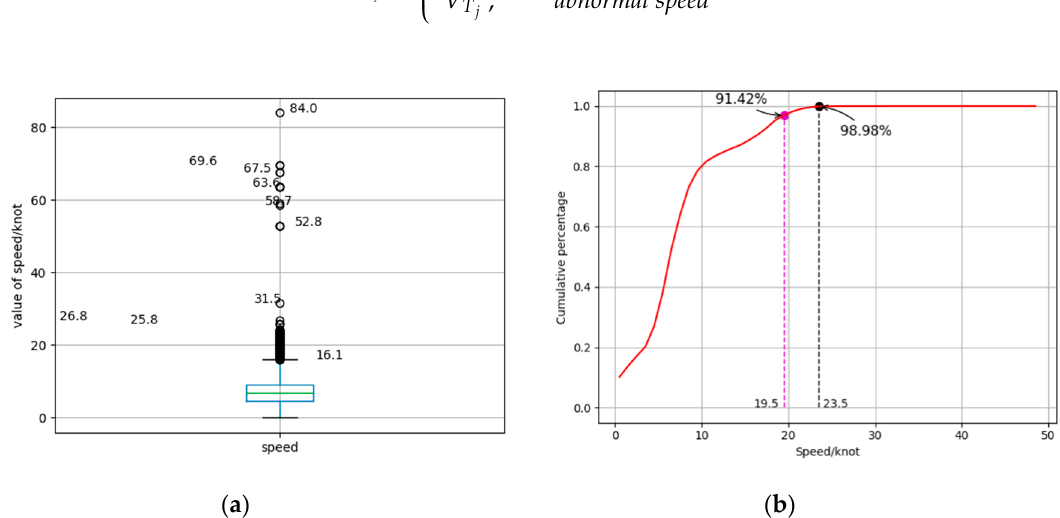
Figure 4. The two forms of AIS data ship speed’s distribution picture: ( a ) box diagram of ship speed, from which it can be seen that the speed is mainly distributed around 15, and a speed greater than 60 is an abnormal speed; and ( b ) probability distribution diagram, where normal data accounts for 98.98% of the total data.